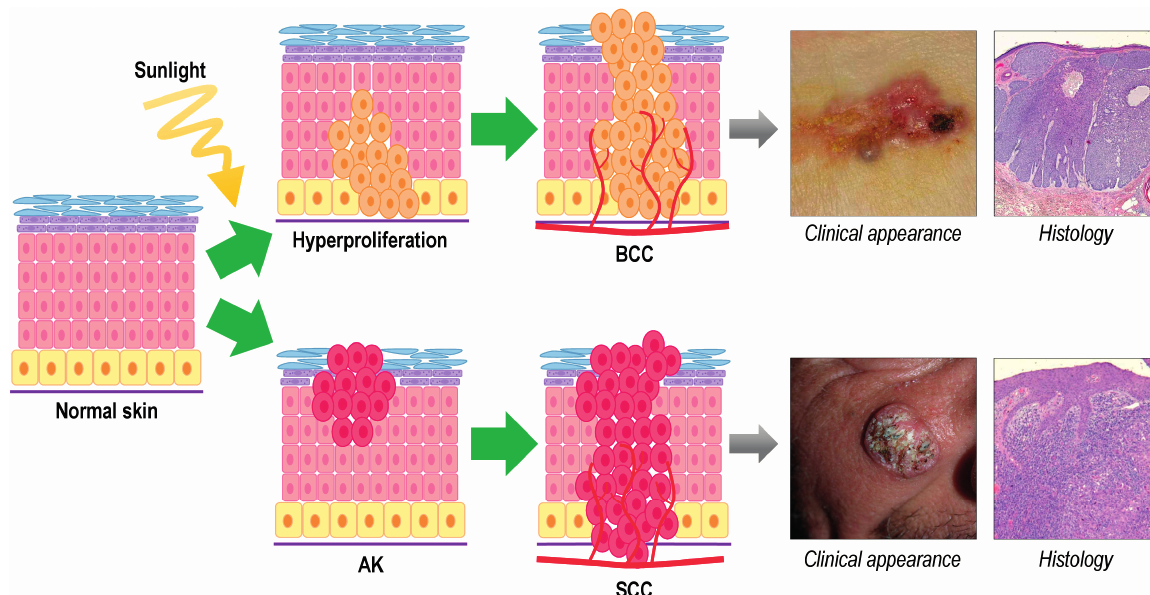
Figure 1. Formation process, clinical and histological appearance of basal cell carcinoma and squamous cell